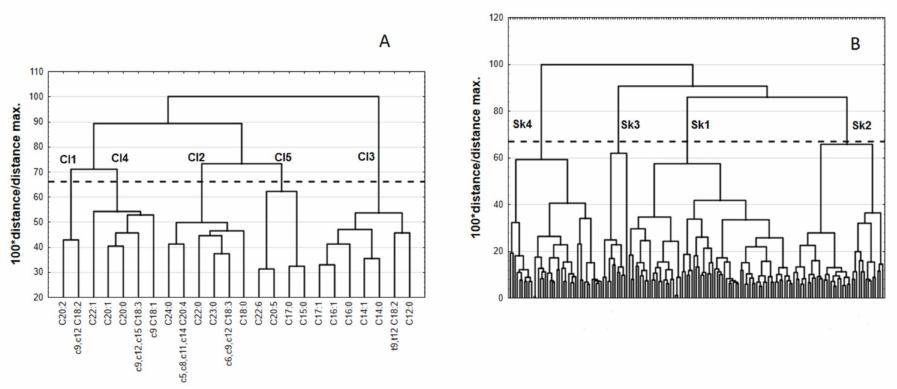
Figure A1. Dendrograms of similarities among fatty acids ( A ) and fatty acids profile of serum samples ( B ). Sk1–Sk4—clusters of serum samples revealed in cluster